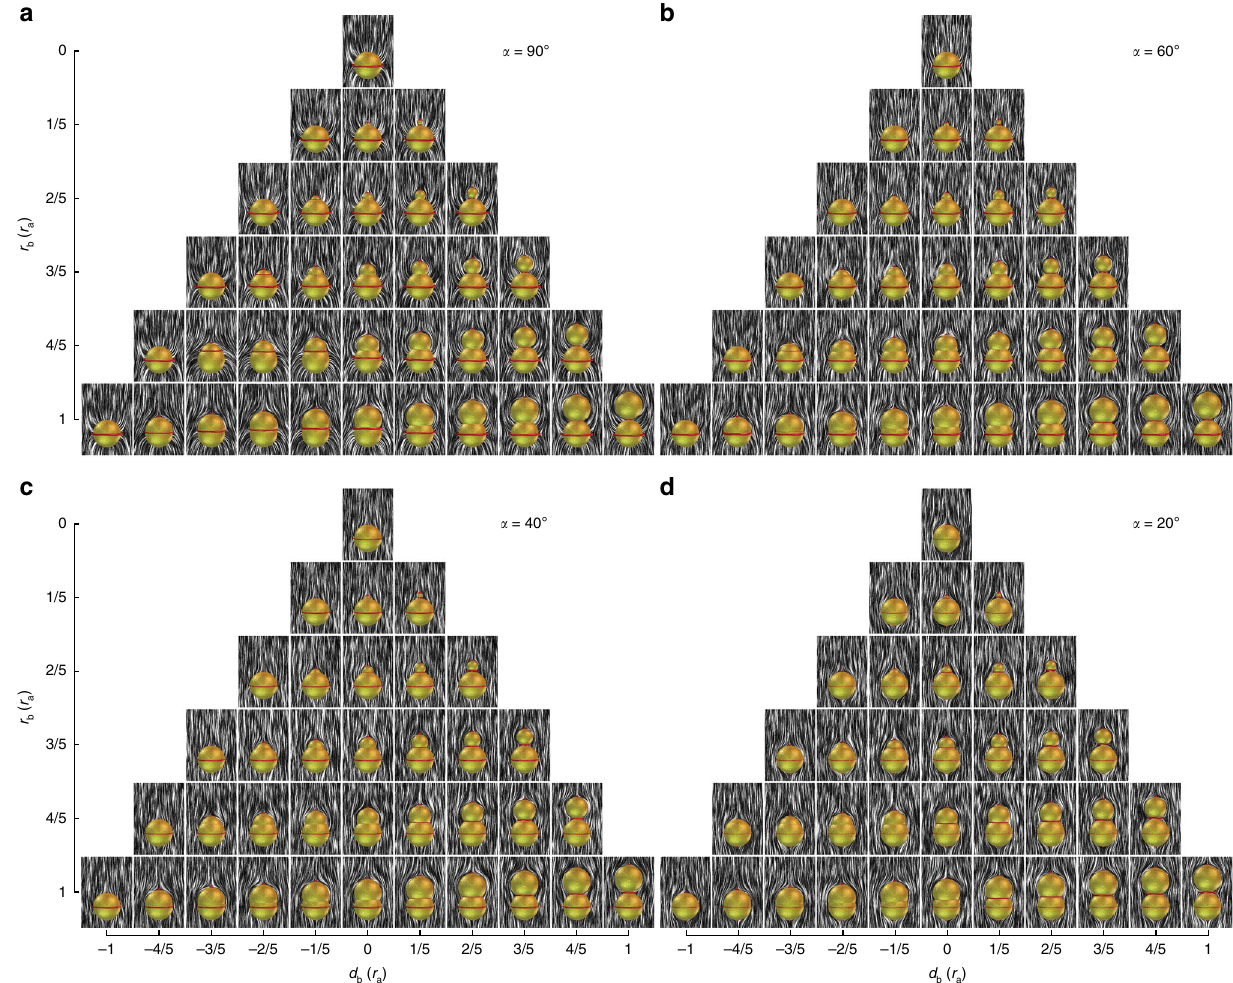
Fig. 5 Gourd-like colloids and corresponding director fi eld structures. Upper sphere has planar degenerate anchoring and lower sphere has tilted anchoring with various angles α . Pyramid-like diagrams show composite colloidal particles (yellow isosurfaces) with variable radius r b and position d b of the upper sphere and conic anchoring at angle: a α = 90°, b α = 60°, c α = 40°, and d α = 20° on the lower sphere. Defect regions are indicated with red isosurfaces ( S = 0.44), whereas the director fi eld is illustrated with black and white streaks. a Defects generally emerge at the lower sphere equator, upper sphere north pole and possibly at the neck where both spheres intersect. The Saturn ring surrounding the lower sphere can move upwards or even to the neck, joining with the neck defect (lower left side of the pyramid). b , c Defects generated by conic anchoring emerge precisely at the equator of the lower sphere, whereas planar degenerate anchoring induces boojum defect at the north pole of the upper sphere. The mismatch between the two anchoring directions forms the surface neck defect. The pro fi le of the neck defect is varied by changing the upper sphere geometry and position; it completely vanishes for composite colloids on the third diagonal from the left side of the pyramid. d The neck defect completely vanishes for composite colloids on the fi rst diagonal from the left side of the